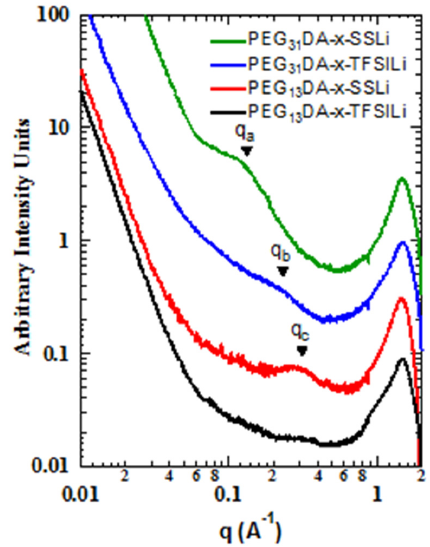
Figure 3. Small and wide angle X-ray scattering data on select crosslinked electrolytes at room temperature. Scattering vectors ( q ) corresponding with ionic aggregation are noted.